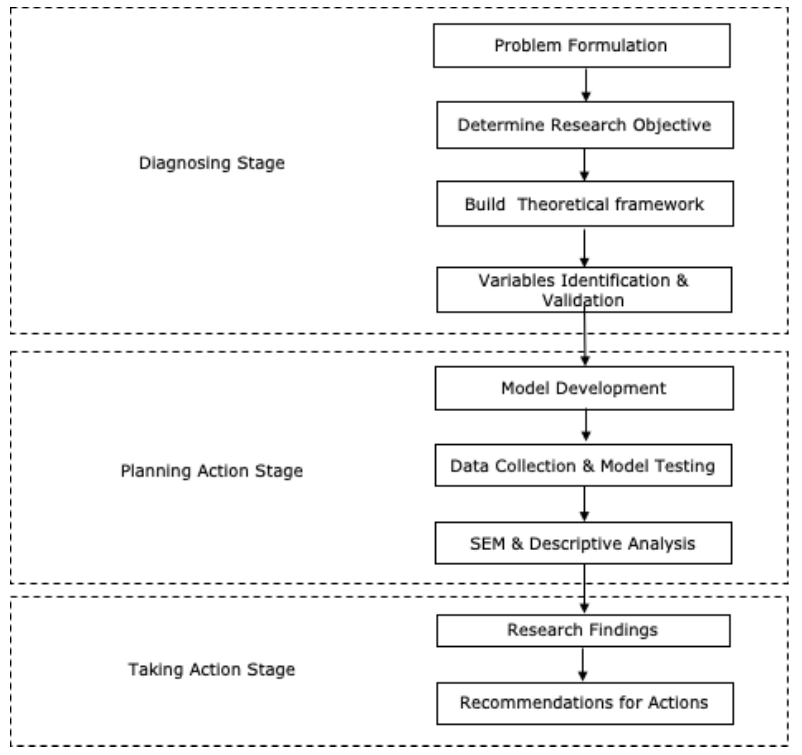
Figure 3. Research Framework (Lewin, 1946; Susman & Evered,